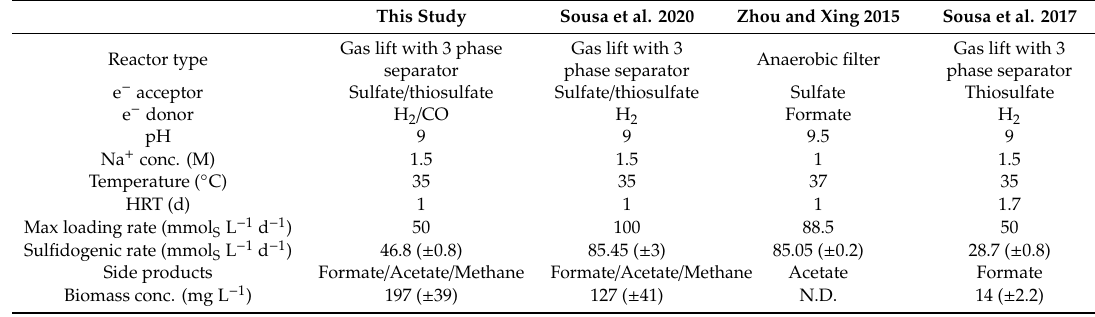
Table 3. Conditions and performance of sulfate and thiosulfate reducing bioreactors operated under haloalkaline conditions.